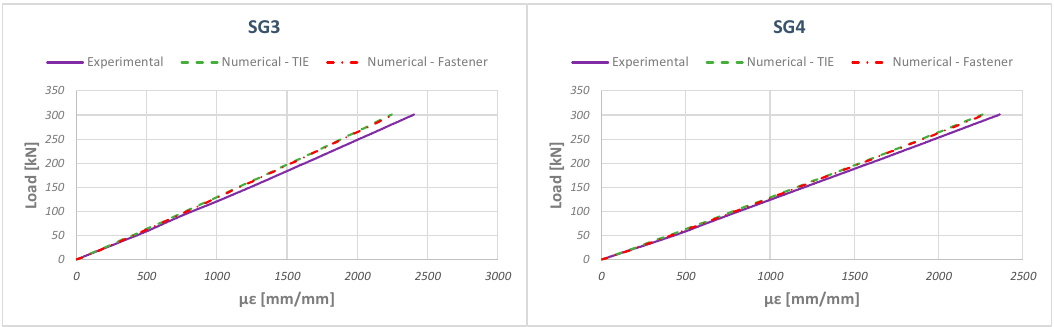
Figure 12. Numerical–experimental comparisons for SG-1 and SG-2: numerical TIE and Fasteners models.